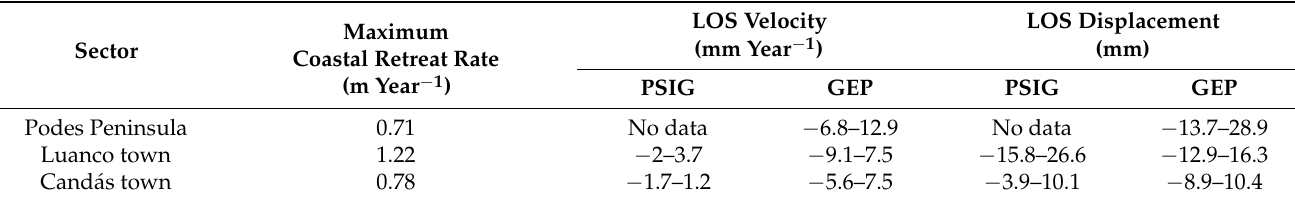
Table 5. Maximum coastal retreat rate (2006-2017) [45], LOS mean velocity and maximum LOS accumulated displacements (2018-2020) for some local